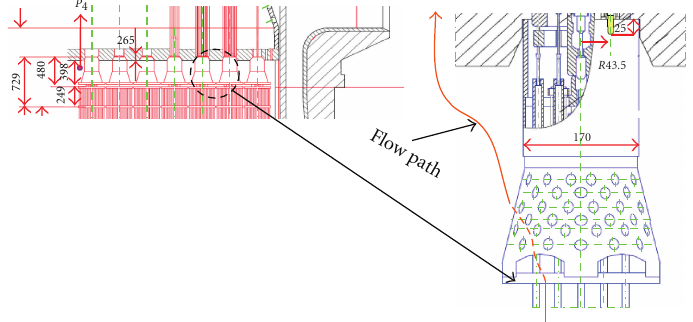
Figure 5: Flow conditions at the fuel assembly head and upper grid